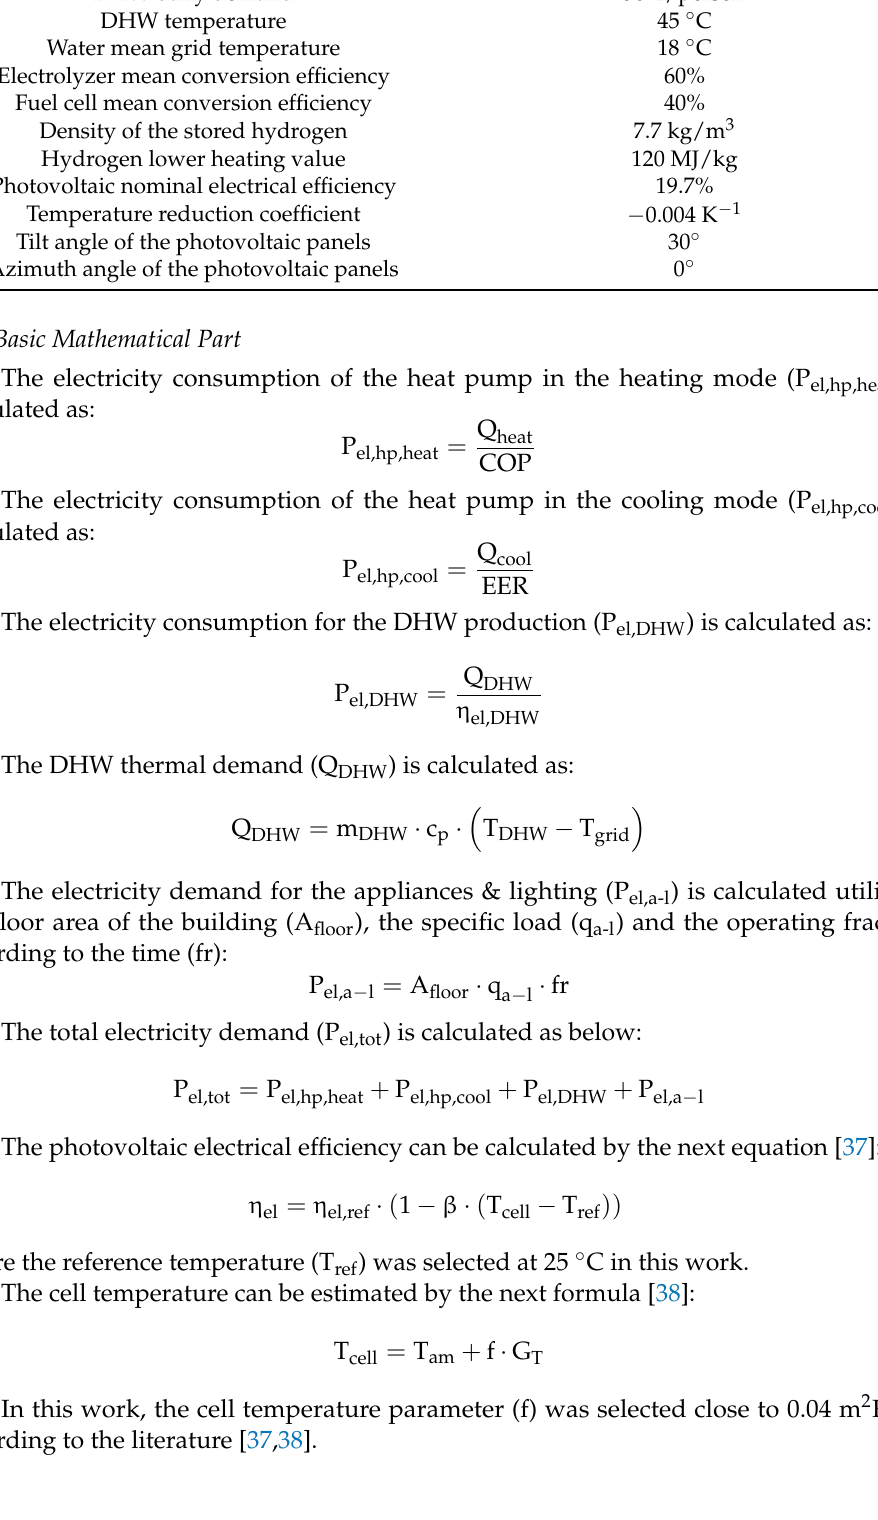
Table 2. Basic data for the investigated system. Parameter Value SCOP of the heat pump SEER of the heat pump